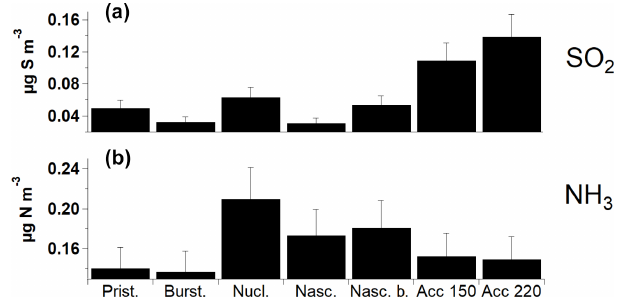
Figure 6. Average concentration of gaseous species, associated with the occurrence of each size distribution category over the entire SMPS data period, at the Zeppelin Mountain site. (a) SO 2 . (b) NH 3